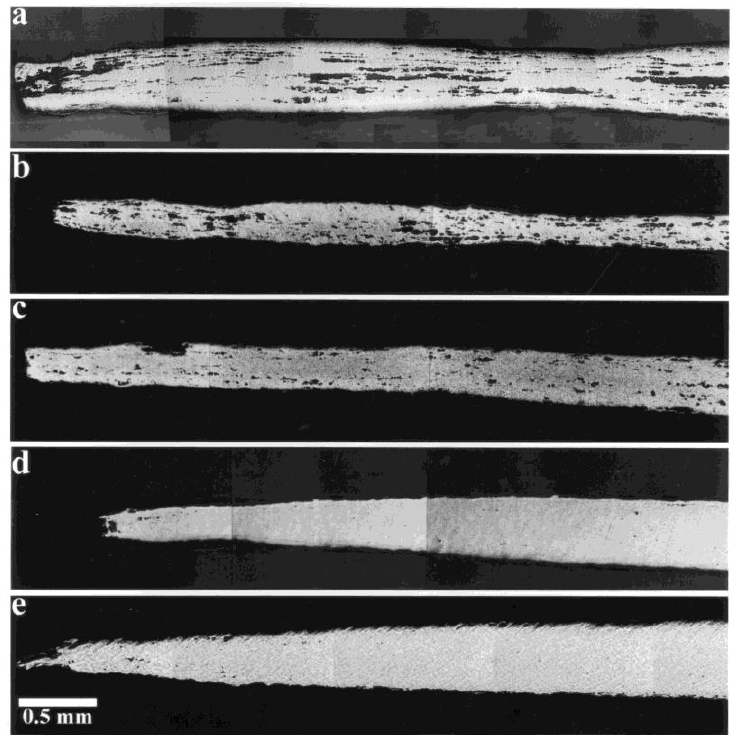
Figure 5. Cavitation in different grades of Zn-22% Al tested at 473 K and a strain rate of 1.33 × 10 −5 . ( a ) Zn-22% Al-014 % Fe; ( b ) grade 1 with 180 ppm impurities; ( c ) grade 2 with 100 ppm impurities; ( d ) high-purity Zn-22% Al; and ( e ) Zn-22% 22% Al-0.13%